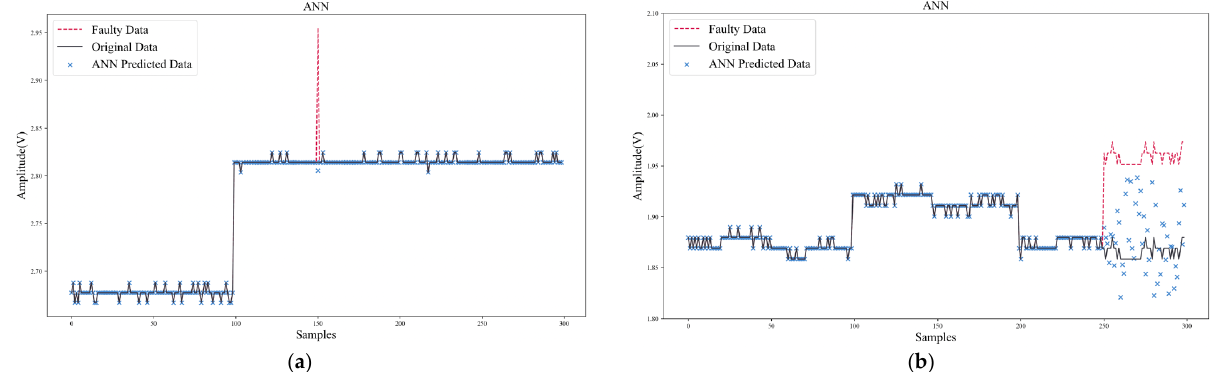
Figure 13. Data recovery of ANN: ( a ) Transient fault; ( b ) Persistent fault.